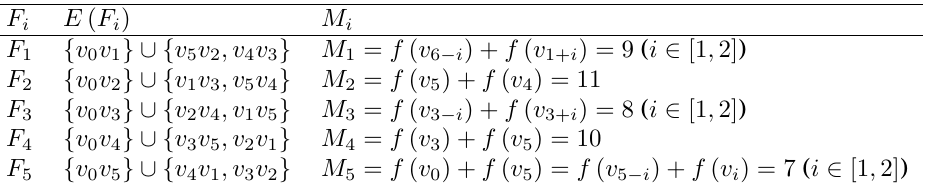
Table 1: A 1 -factorization of K 6